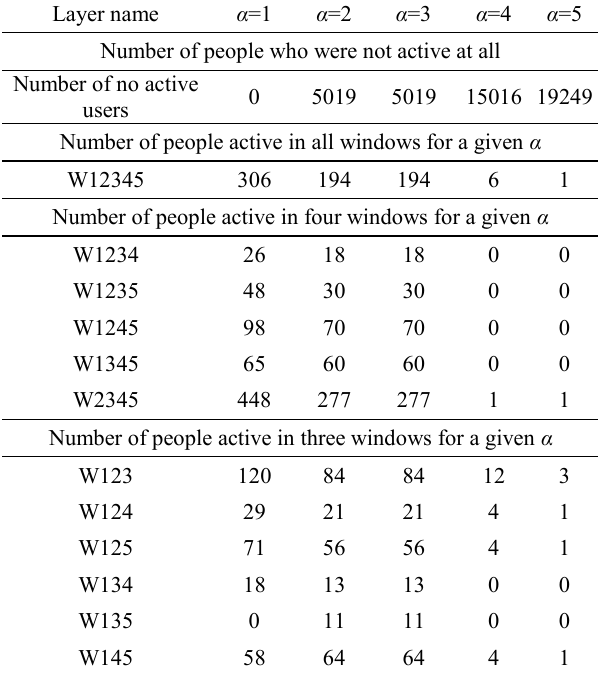
Table 6 Number of active people for each α value and for different windows and windows combination Layer name Number of people who were not active at all Number of no active users Number of people active in all windows for a given